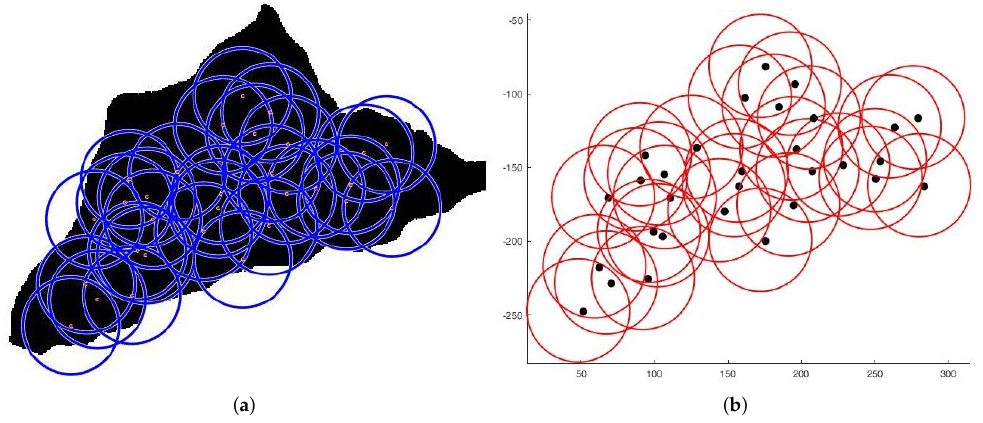
Figure 12. Deployment on third area. ( a ) Final positioning. ( b ) Connectivity